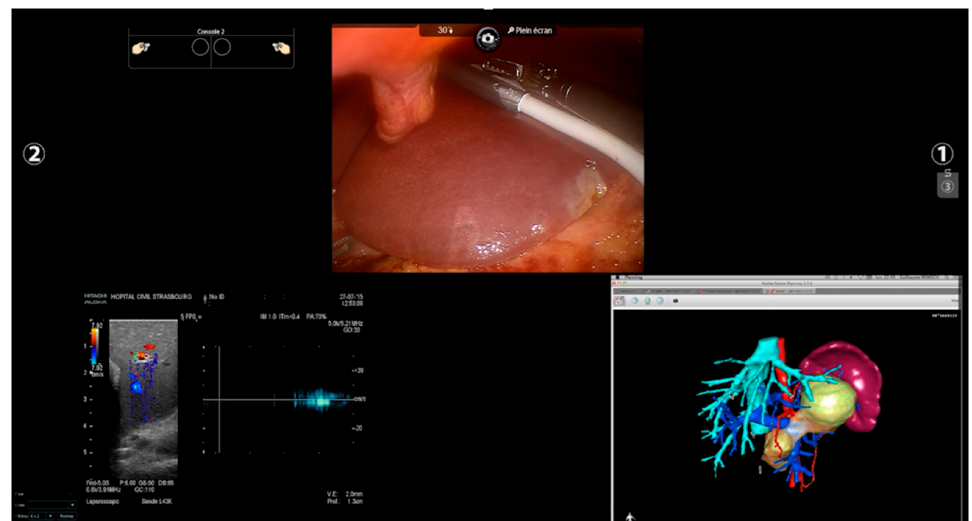
Figure 4. Robotic “split ‐ view”. Through a dedicated probe and a specific software, the surgeon can shift from to the endoscopic to the ultrasound view or create a split ‐ view with both the images. In this figure, a 3D model was added intraoperatively at the same time to check the tumoral vascular relationship studied preoperatively.